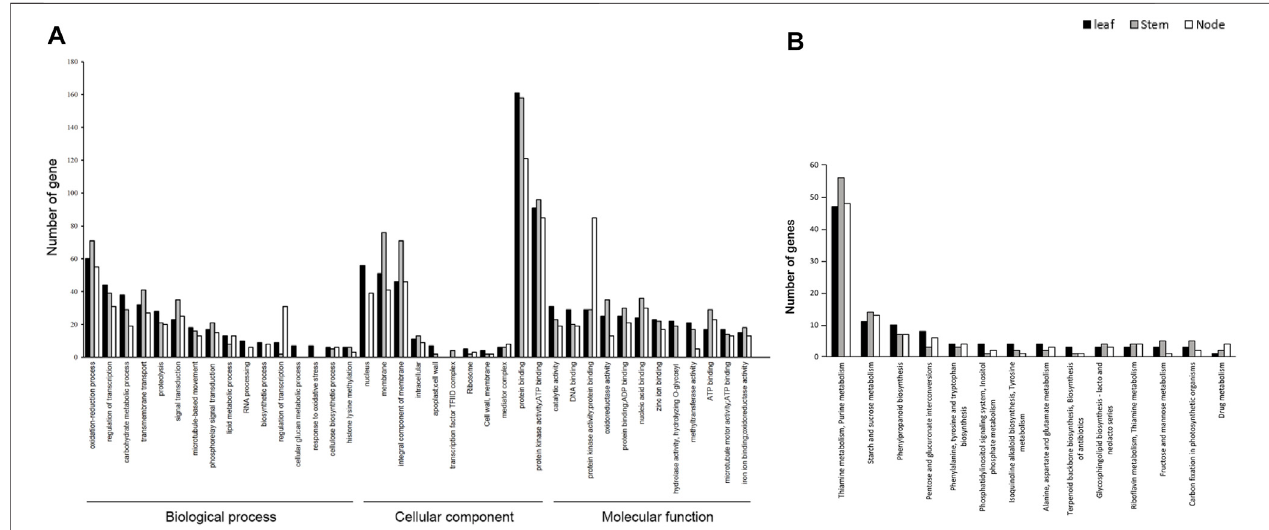
FIGURE 3 | Gene Ontology (GO) functional classi fi cation and Kyoto Encyclopedia of Genes and Genomes (KEGG) classi fi cations of DEGs of leaves, stems, and nodes. (A) GO analysis of differentially expressed genes (DEGs). GO describes number of most enriched DEGs with three independent categories: biological process, cellular component, and molecular function. The x-axis represents the GO terms and the y-axis the number of unigenes. (B) KEGG pathway of DEG terms grouped into 15 categories. The x-axis represents KEGG terms and the y-axis number of unigenes.